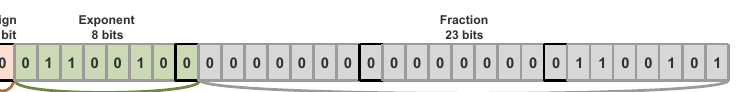
Figure 9. The structure of 4 bytes float data.